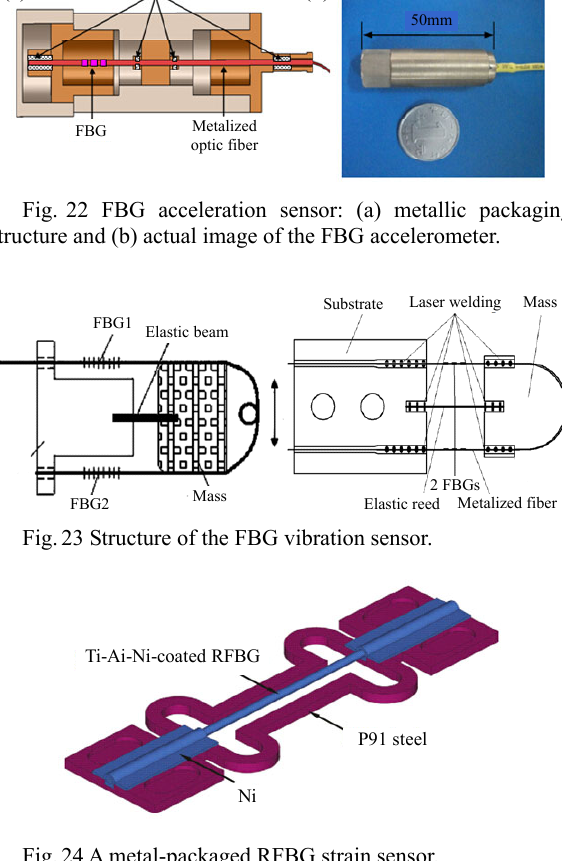
Fig. 24 A metal-packaged RFBG strain